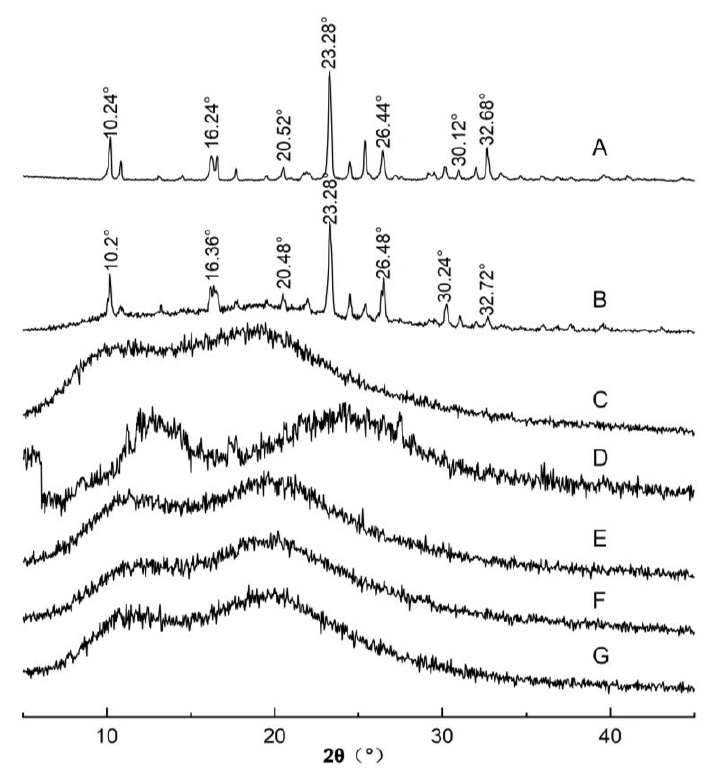
Figure 3. PXRD spectra of FEL (A), FEL PM (B), Soluplus ® (C), FEL PA (D), faSDDS SE (E), faSDDS QC (F) (F) and faSDDS HME and faSDDS HME (G).